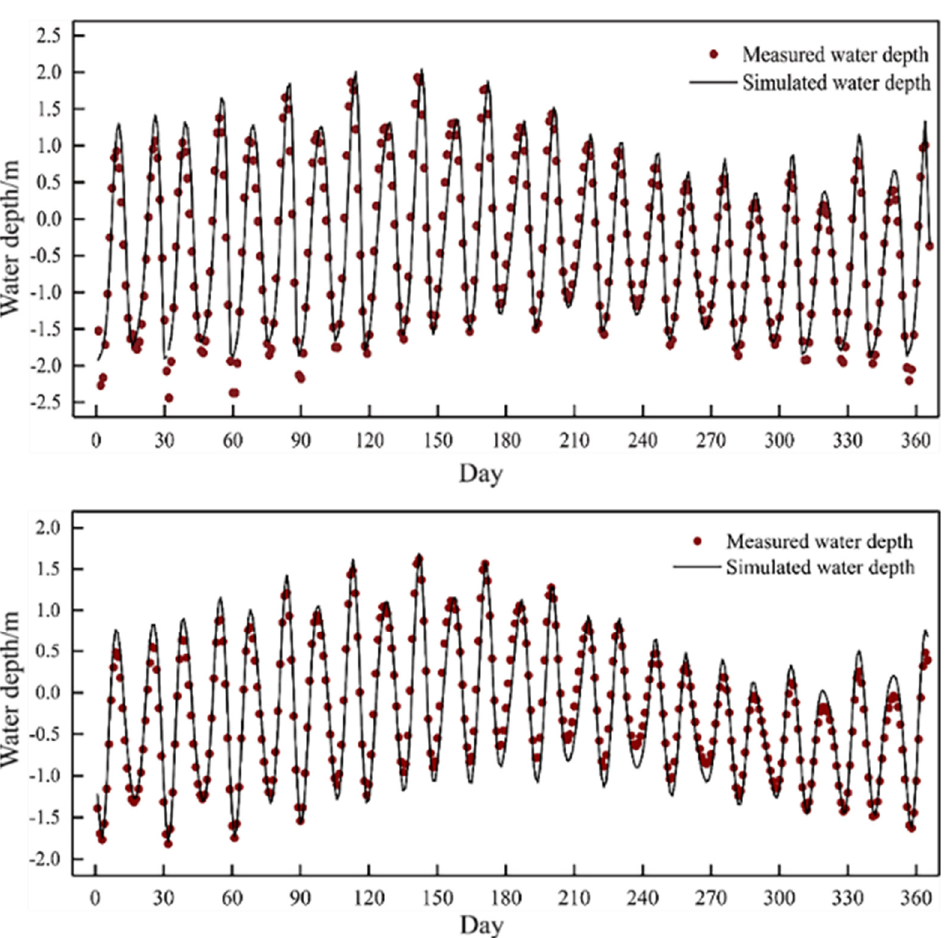
Figure 4. Actual and calculated tide level at Huludao and